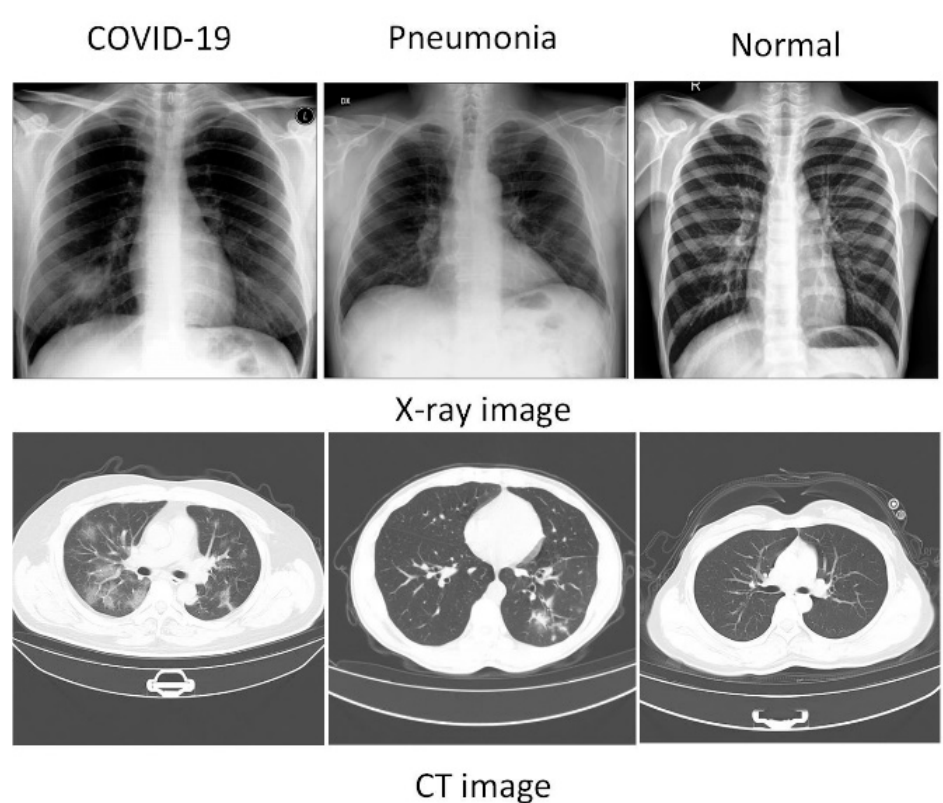
Figure 2. The X-ray and CT images of COVID-19.